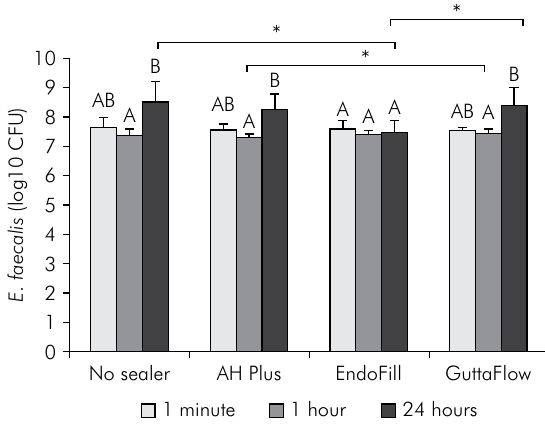
Table. Mean inhibition zones and standard deviation observed Figure. Enterococcus faecalis survival after incubation with in the agar diffusion test (ADT) for tested sealers. sealers in different experimental periods in the direct contact AH Plus test (DCT). Distinct letters indicate statistically significant difference between periods for each sealer. Horizontal bars indicate statistically significant difference between sealers in each period (*p <